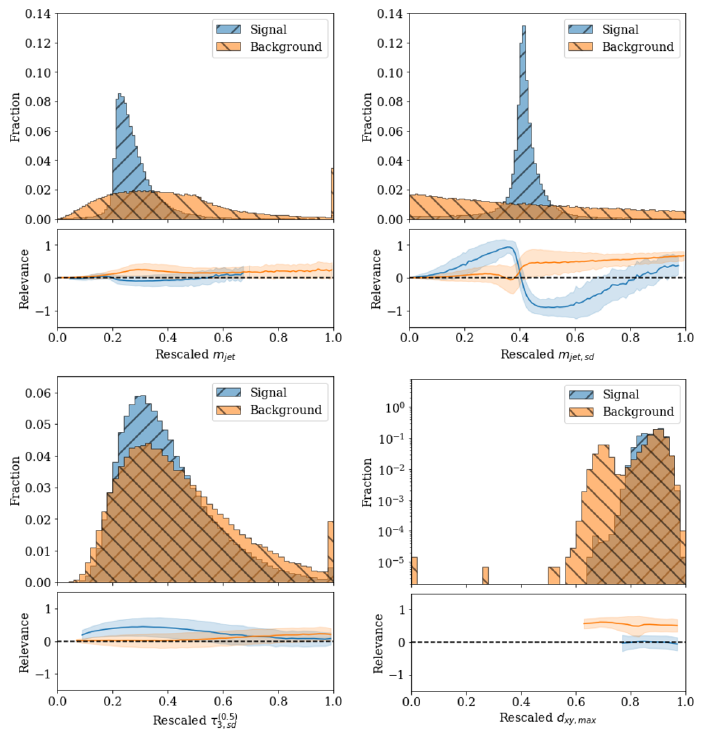
Figure 18. Histograms with profiles of LRP relevances normalized per event and averaged over four models. Signal and background are the Zbb and QCD samples,